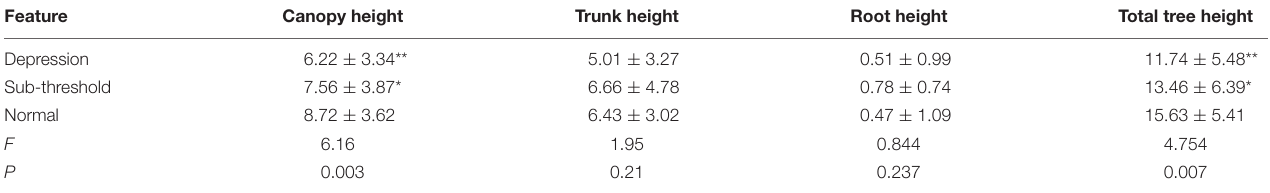
TABLE 2 | Height (cm) of canopy, trunk, root, and whole tree in the groups.